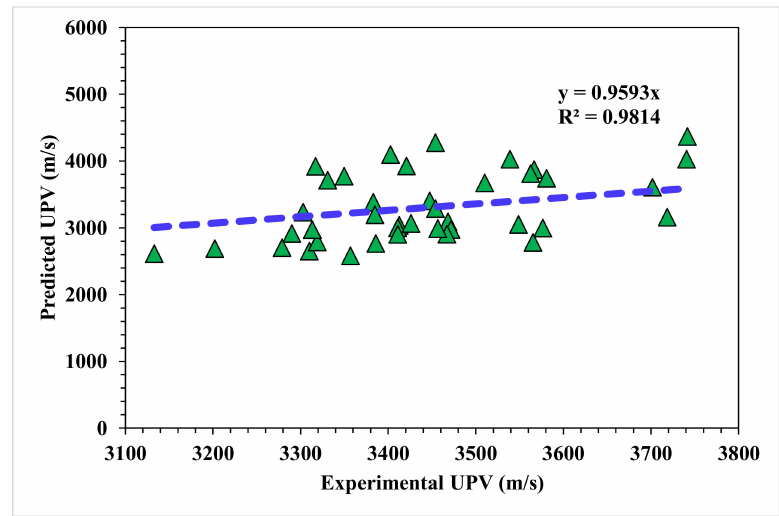
Figure 12. Random Forest model experimental and predicted results.